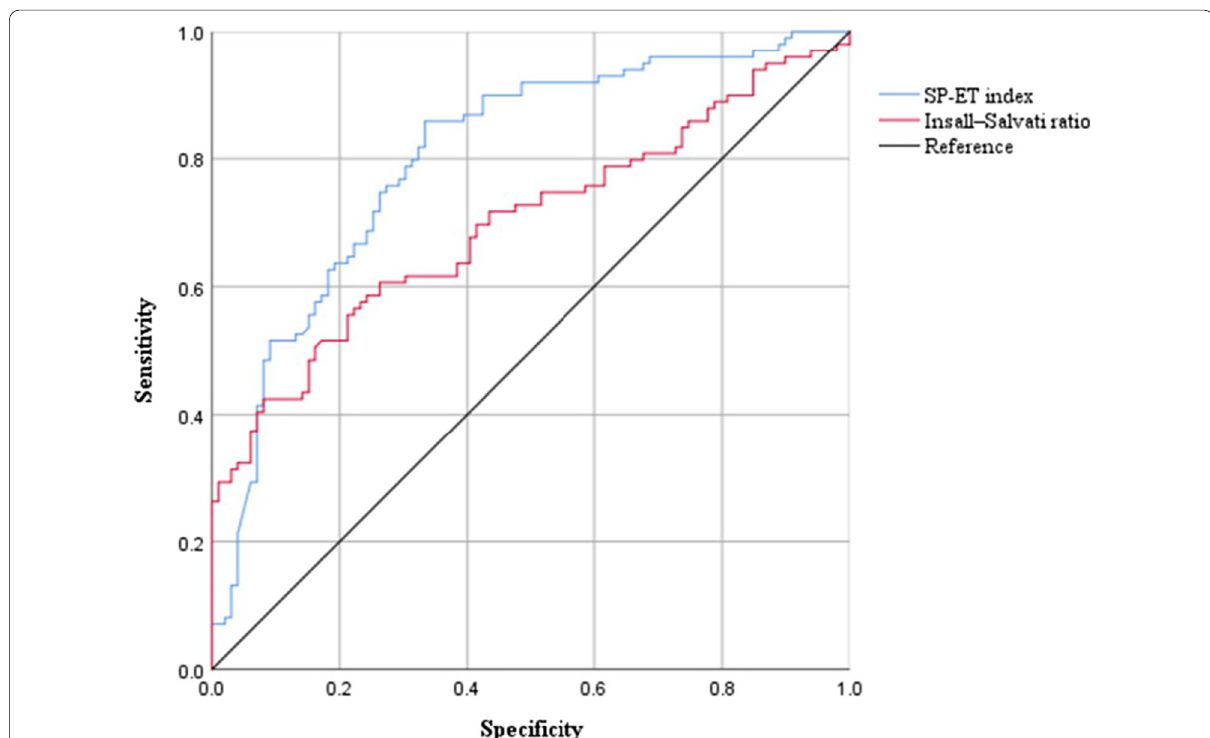
Fig. 5 The receiver operating characteristic (ROC) curves of SP-ET index and Insall–Salvati ratio. The ROC of SP-ET index was the blue curve (area under curve (AUC) 0.803); the ROC of Insall–Salvati ratio was the red curve (AUC =